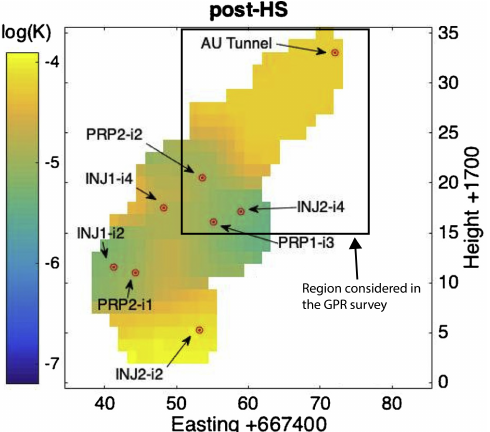
Figure 12. Inversion result of the hydraulic conductivity, K , distributions reconstructed using the peak arrival times of dye tracer breakthrough curves after the hydraulic shearing stimulations of the ISC experiment. Figure modified from Kittilä et al.